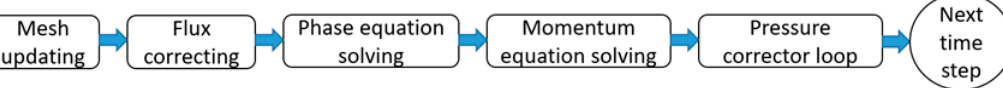
Figure 1. The flow chart of the solution.